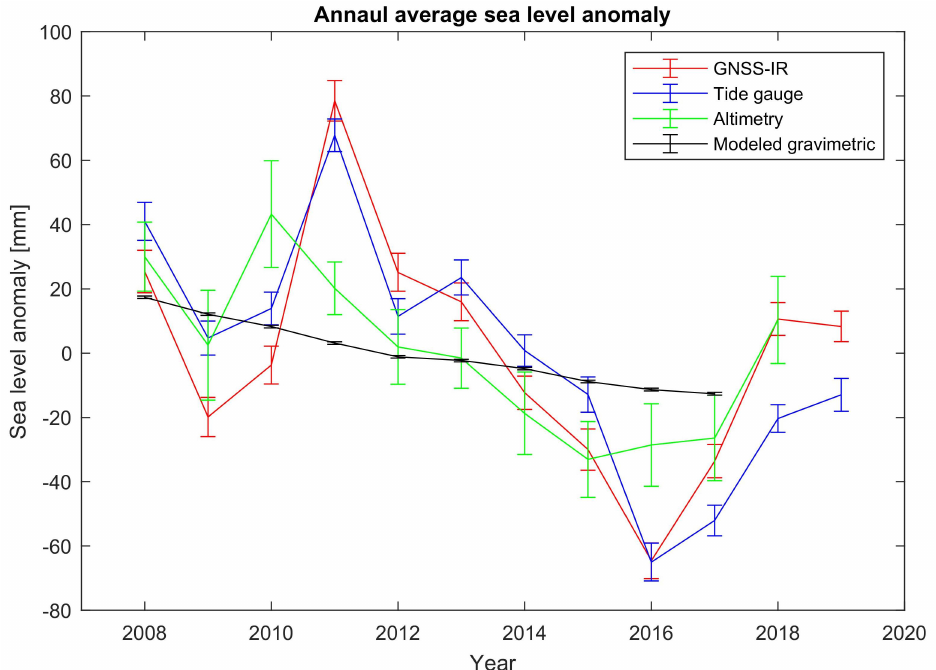
Figure 3. Annual average sea level change at Thule using GNSS-IR, TG and altimetry. The error bars illustrate the annual standard deviation of the mean as described in Section 2. The figure also includes variations in the modeled gravity related sea